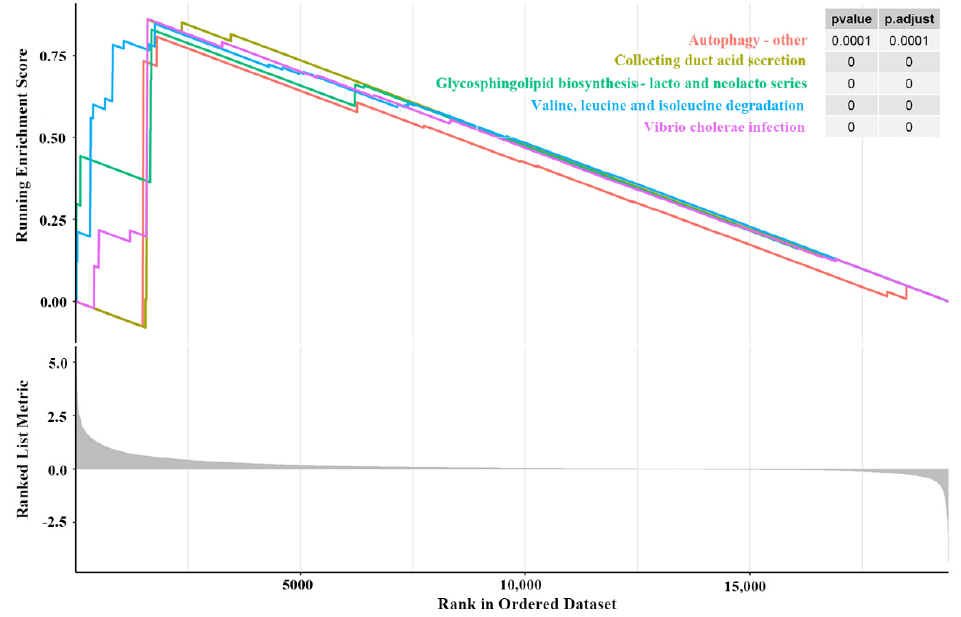
Figure 5. GSEA between the two risk groups in the TCGA cohort.